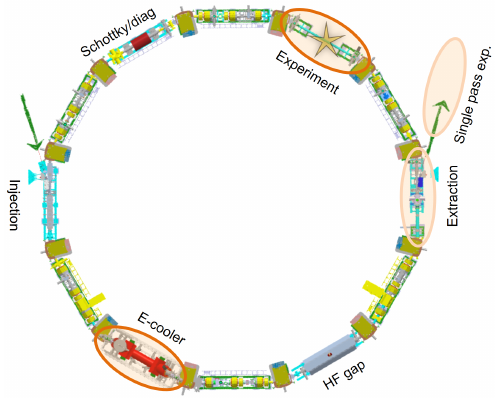
Figure 1. Schematic overview of CRYRING@ESR. The four areas relevant to experimental installations are